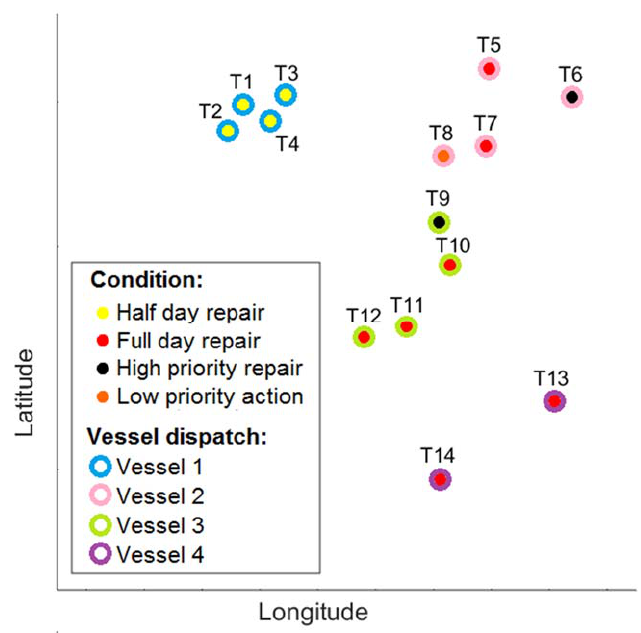
Figure 6. The status of turbines requiring maintenance and a vessel dispatch plan for Case Study 2. Table 3. Comparison of the policy devised by the operators vs. generated by the tool.